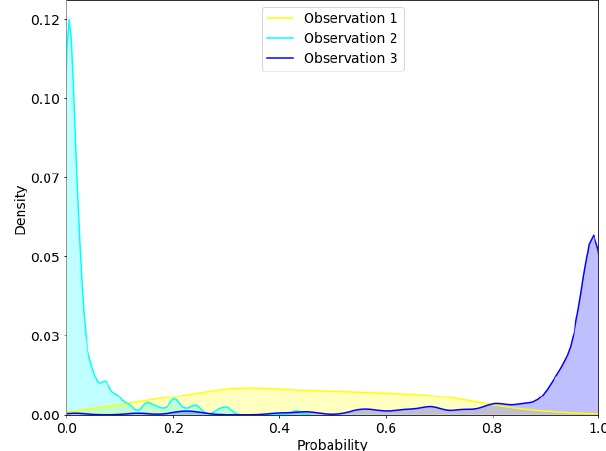
Figure 9. Kernel density estimation (KDE) of the three observations in Figure 8. We have used the seaborn visualization library, i.e., Gaussian kernel with Scott method for estimation the kernel bandwidth. The KDE smoothens the empirical distribution, thus exceeding the estimate beyond the possible range of [ 0,1 ] . We thus limit the plot to be within the bounds, which means that this KDE does not summarize to